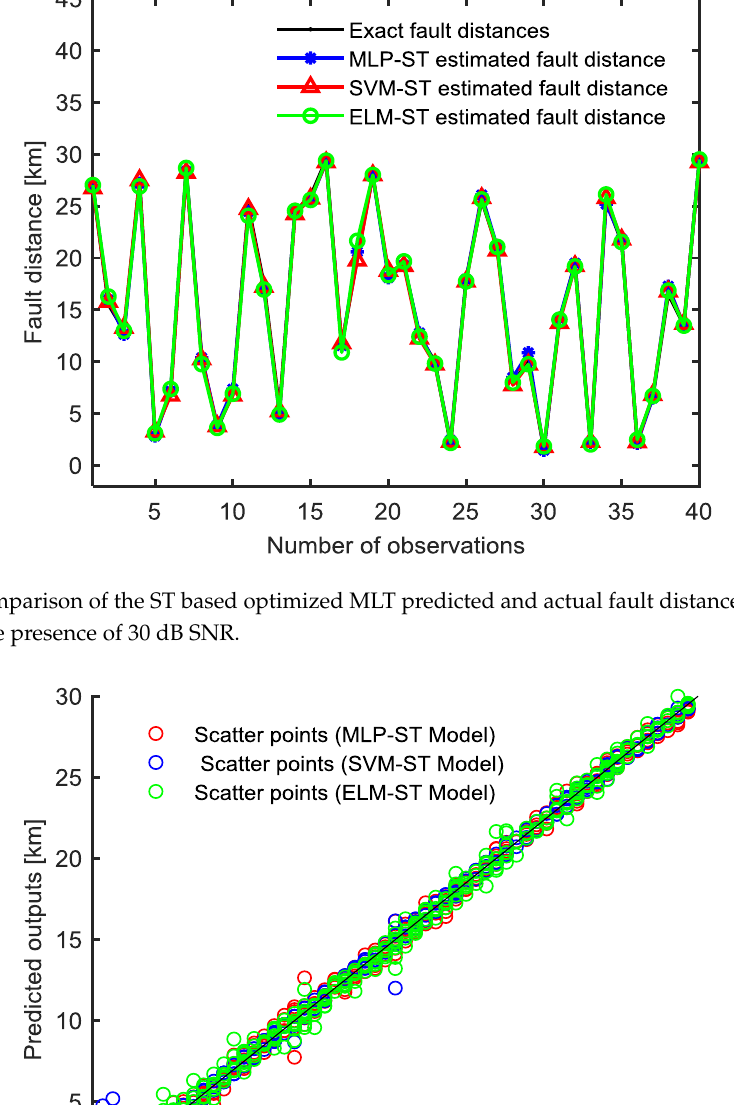
Figure 10. Comparison of the ST based optimized MLT predicted and actual fault distances, for the test dataset, in the presence of 20 dB SNR. Additionally, the RMSE, MAPE, RSR, and PBIAS were quite low, whereas the R 2 , WIA, and NSCE were almost unity for the optimized MLT approaches, indicating the strength and the effectiveness of the approaches, for all types of faults, even in the presence of measurement noise. However, the performance of the developed scheme degrades a bit in the presence of measurement noise, but it can still estimate fault locations with acceptable accuracy.